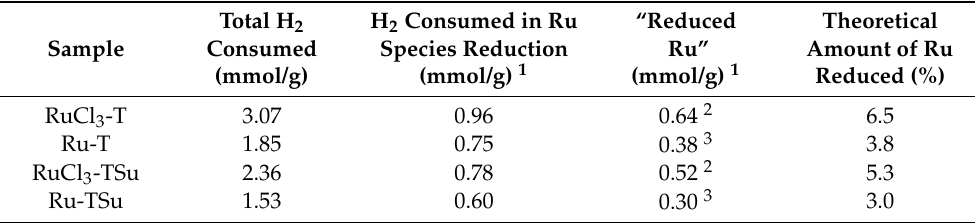
Table 4. H 2 consumption in TPR experiments and calculated amount of reduced Ru.